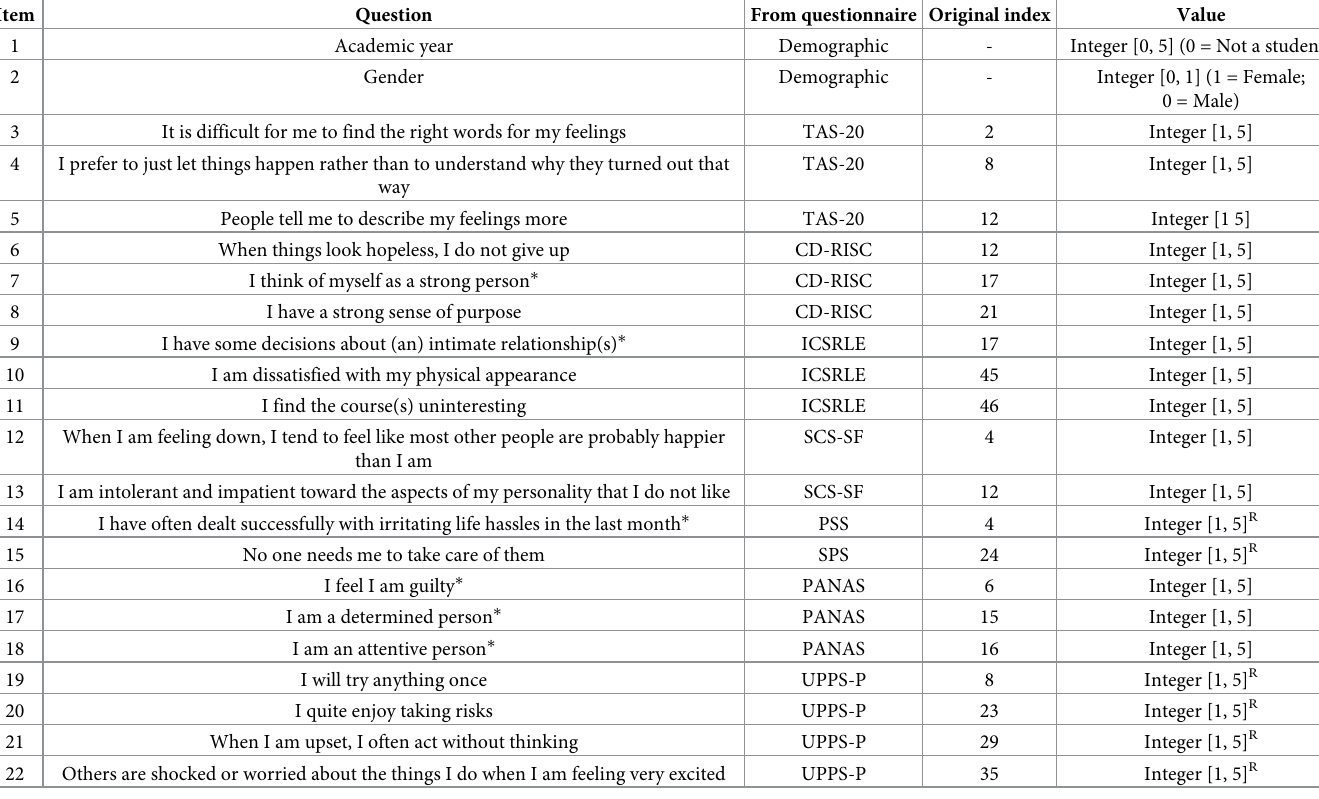
Table 6. Questions of the abstracted dataset.